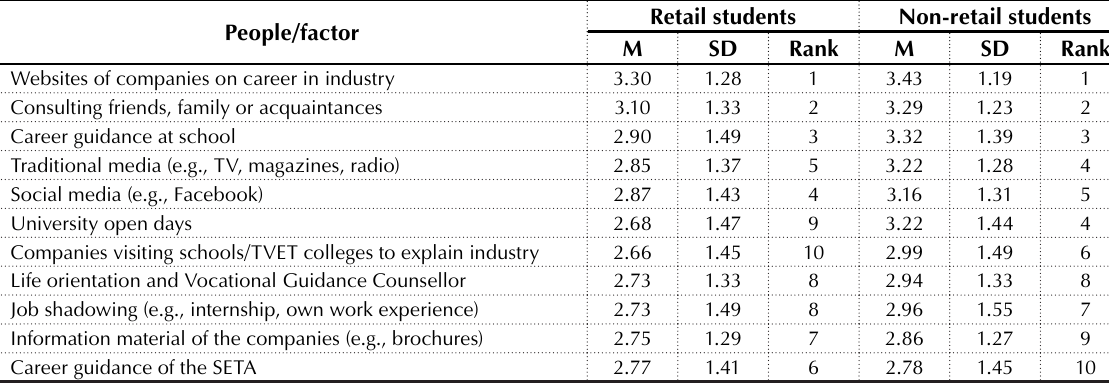
Table 5. Retail and non-retail students’ ratings of information